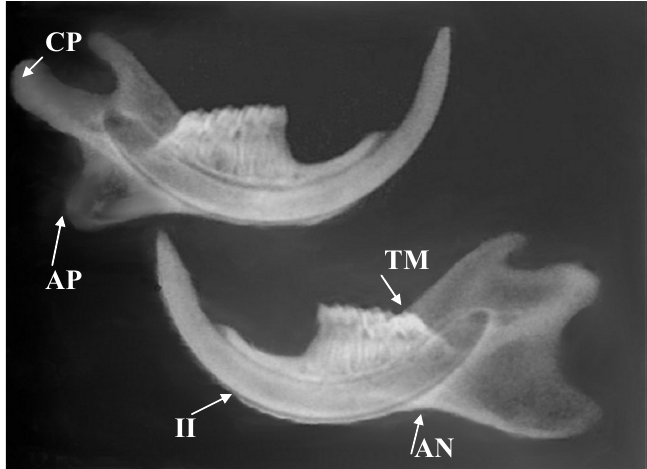
FIGURE 2 - Lateral radiograph of